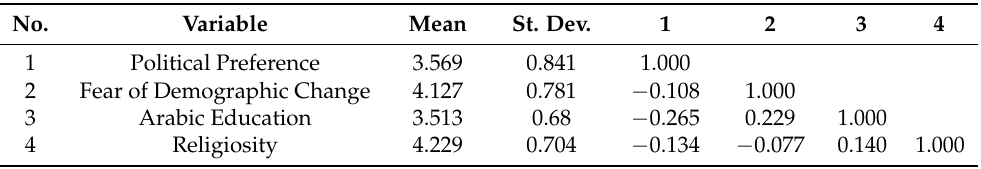
Table 1. Mean, standardized deviations, and correlations of constructs.